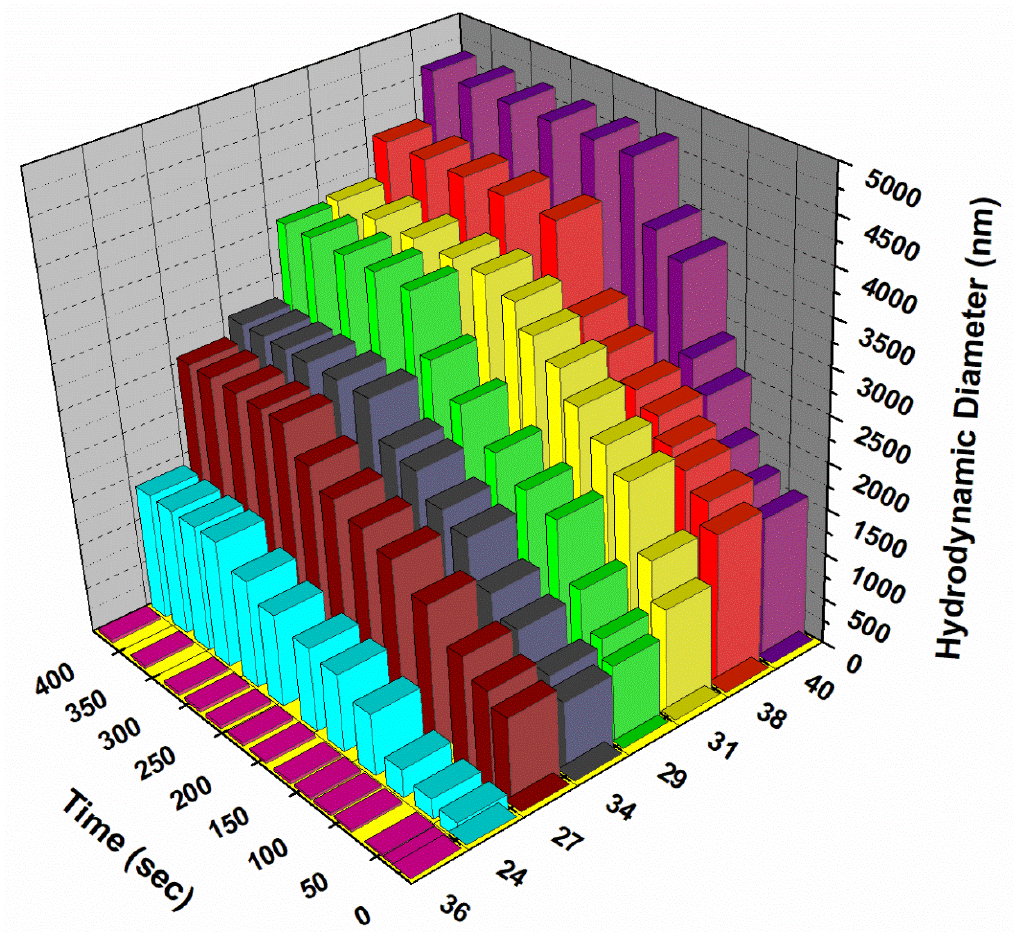
Figure 1. 3D DLS plots of the cross-linking kinetics of ConA in the presence of mannosylated dendrimers 24 , 27 , 29 , 31 , 34 , 38 and 40 and the glucosylated dendrimer 36 taken as negative control.